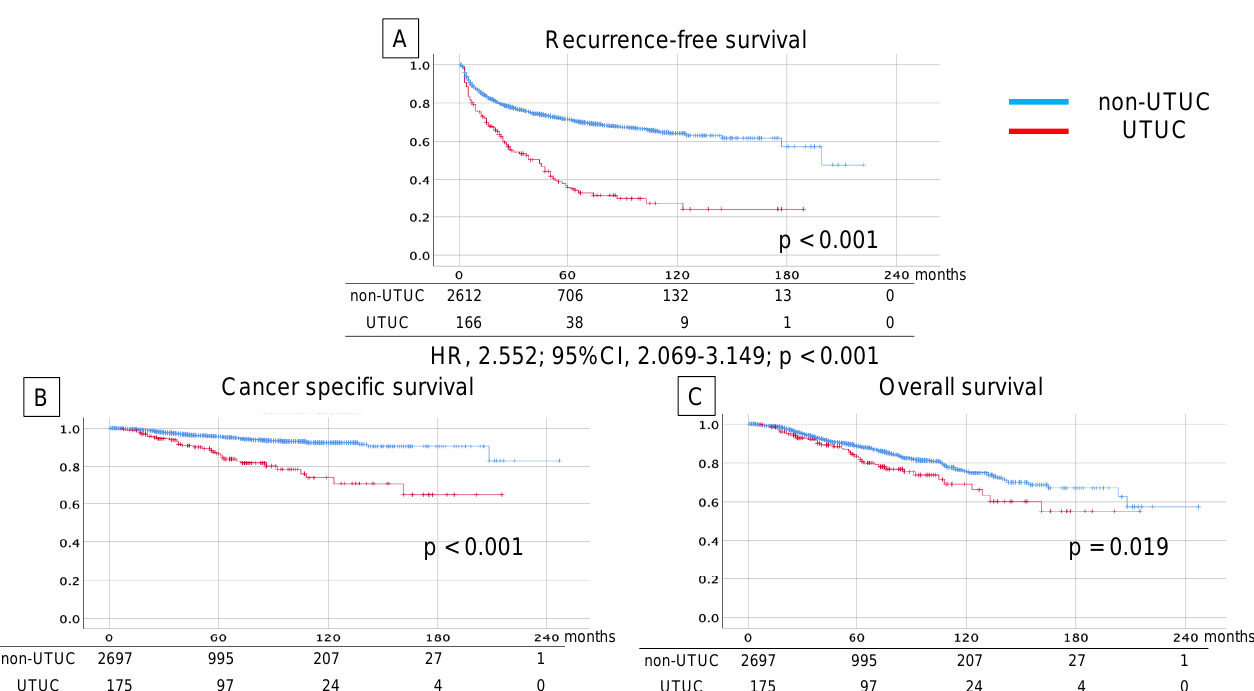
Figure 1. Kaplan–Meier curve of recurrence-free survival ( A ), cancer-specific survival ( B ), and overall survival ( C ) in non-muscle-invasive bladder cancer patients with and without subsequent diagnosis of upper tract urothelial carcinoma after intravesical bacillus Calmette-Guerin (BCG) therapy.